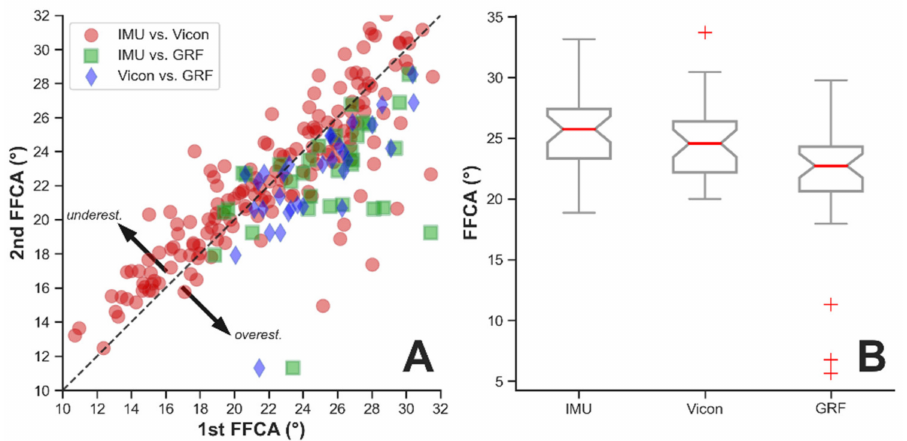
Figure 7. Comparison of FFCA computed based on IMU, Vicon and GRF: ( A ) Differences in FFCA computed based on IMU, Vicon and GRF. The “1st FFCA” is the first group listed in the legend entry (e.g., IMU in “IMU vs. Vicon”), while the “2nd FFCA” is the second group listed (e.g., Vicon in “IMU vs. Vicon”). For example, blue squares show how Vicon-based FFCA compares to GRF-based FFCA; ( B ) Boxplot showing the mean differences in FFCA computed based on IMU, Vicon and GRF. Red crosses indicate